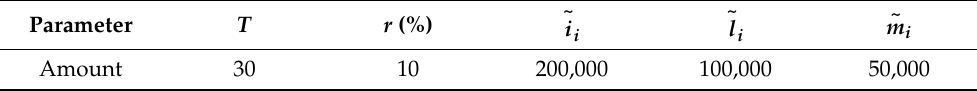
Table 13. Model parameters in Topology 2.